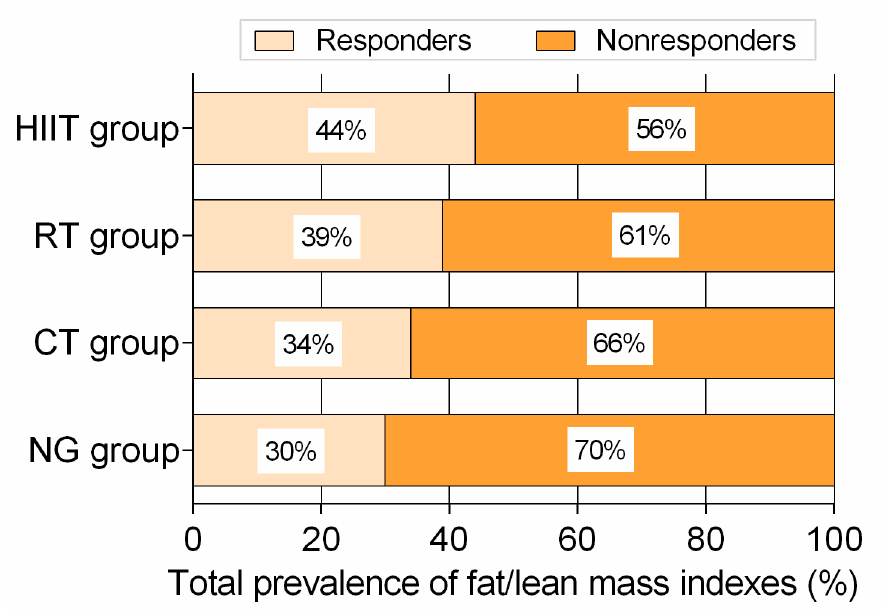
Figure 6. Total prevalence of responders vs. non-responders according to technical error of measurement for 3 fat mass, 3 lean mass, and 3 fatness distribution-related from each group intervention at week 12. NG: nutritional guidance alone group; HIIT: high-intensity interval training group; RT: resistance training group; CT: combined training (HIIT + RT) group.